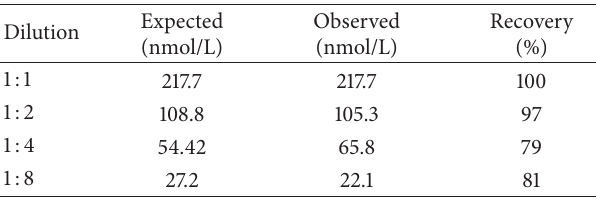
Table 2: Serum concentration and percentage recovery of cortisol using the VIDAS method on bovine serum with high cortisol concentration.